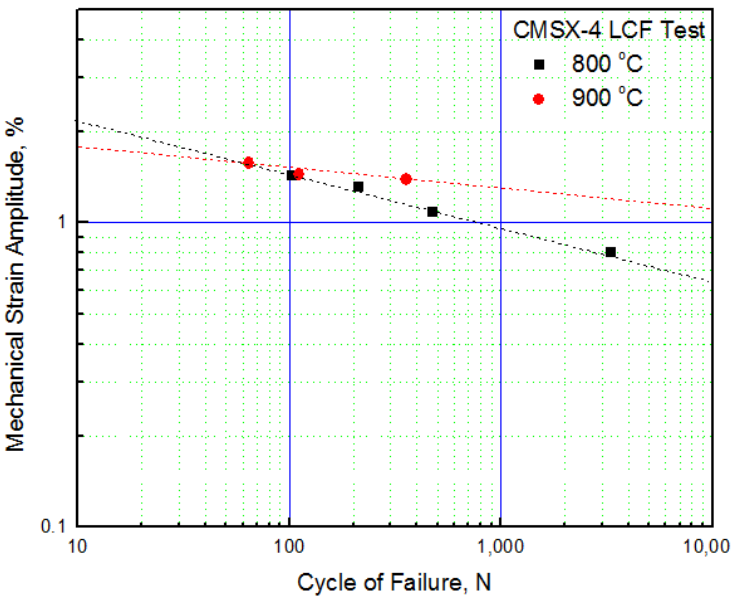
Figure 4. Strain–failure cycle curve (CMSX-4).